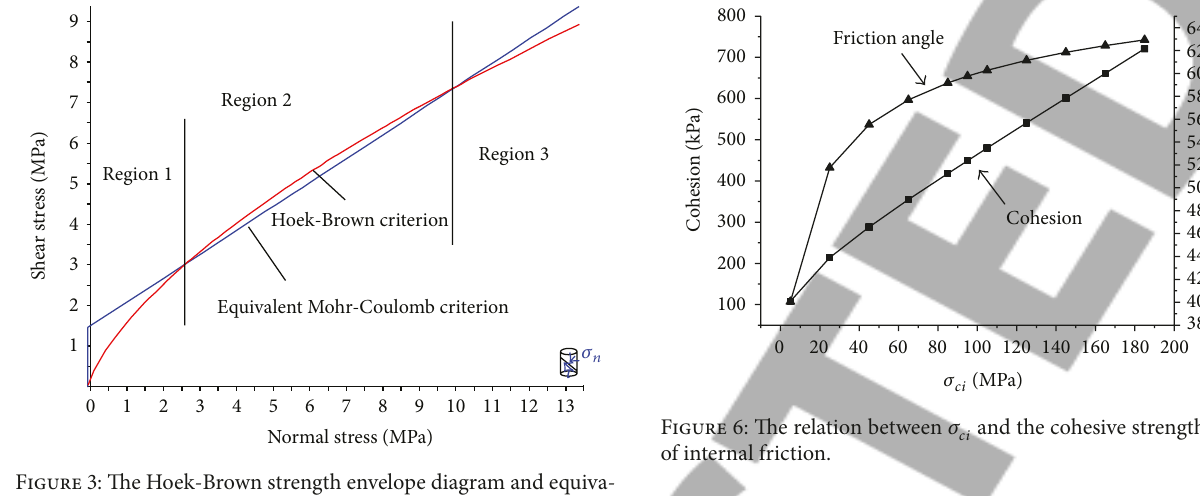
Figure 3: The Hoek-Brown strength envelope diagram and equiva- lent Mohr-Coulomb strength envelope diagram.